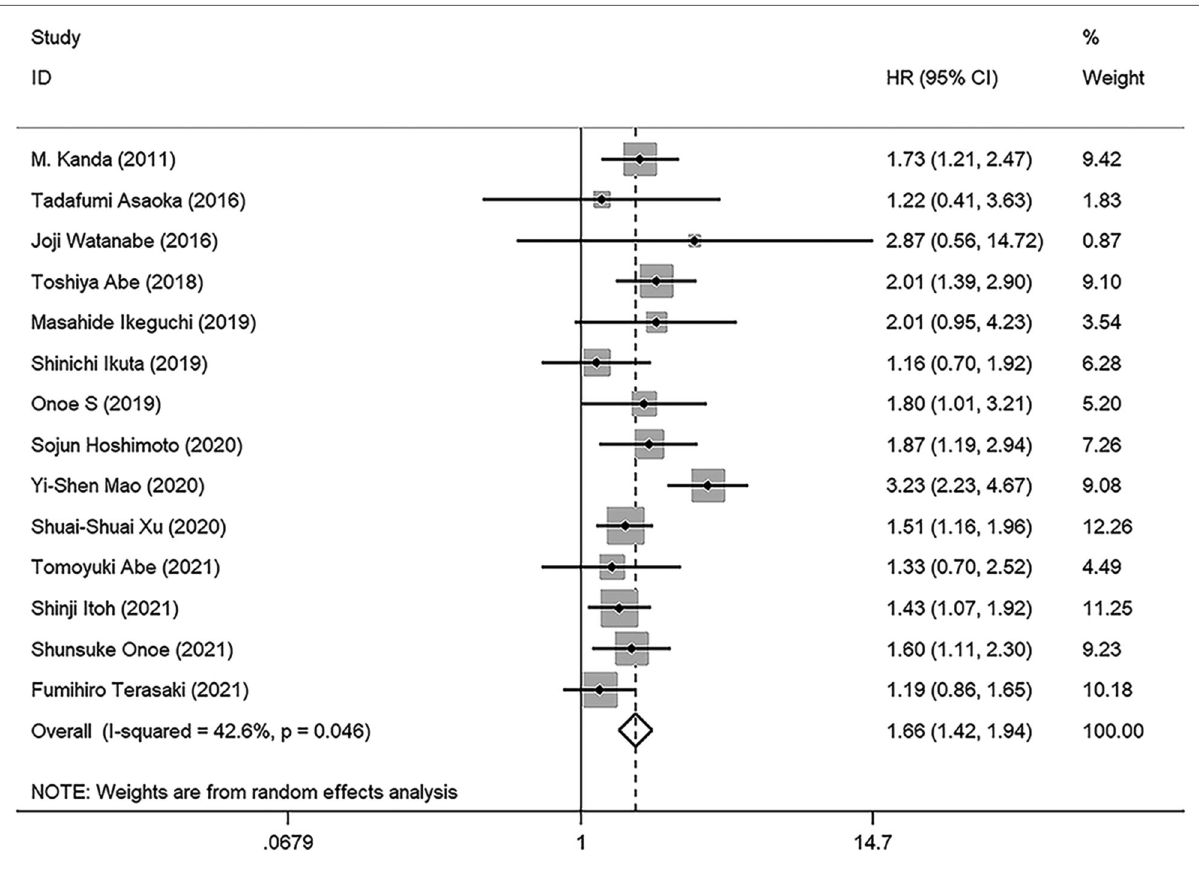
FIGURE 2 Forest plot of the association between PNI and OS. (OS, overall survival; HR, hazard ratio; CI, con fi dence